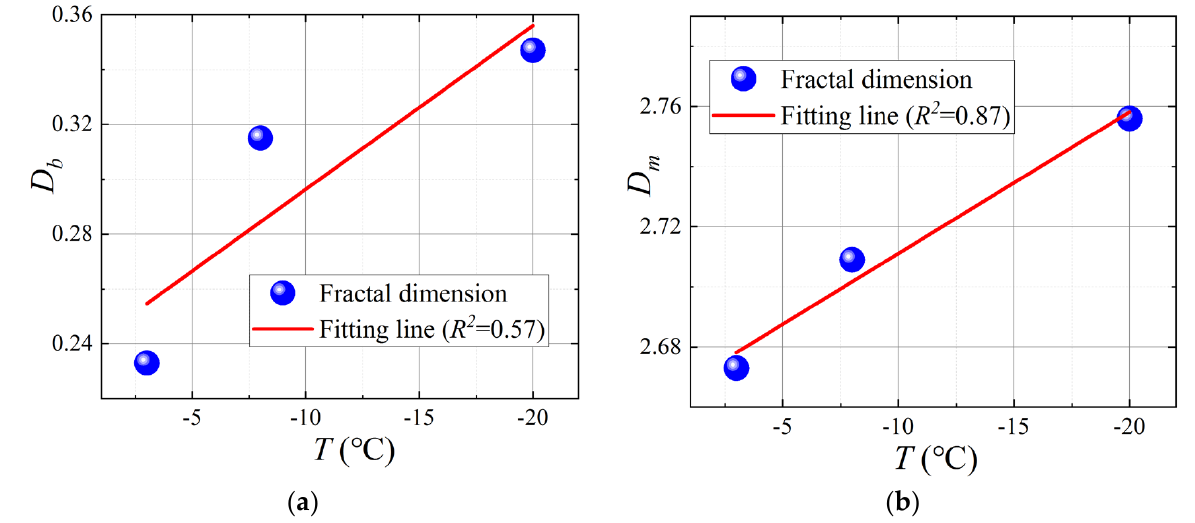
Figure 13. Fractal dimension under various freezing temperatures: ( a ) fractal dimension for bound fluid; ( b ) fractal dimension for movable fluid.